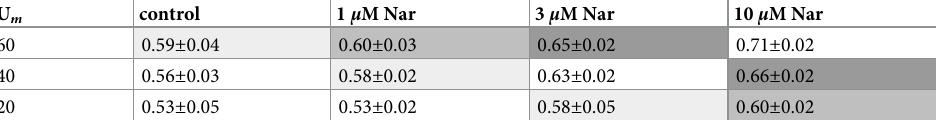
Table 1. The mean open state probabilities obtained at different membrane potentials and naringenin concentra- tions. The cells representing the groups of recordings for which the classification analysis by ML was performed are coloured by the same shade of gray. The U values are given in m